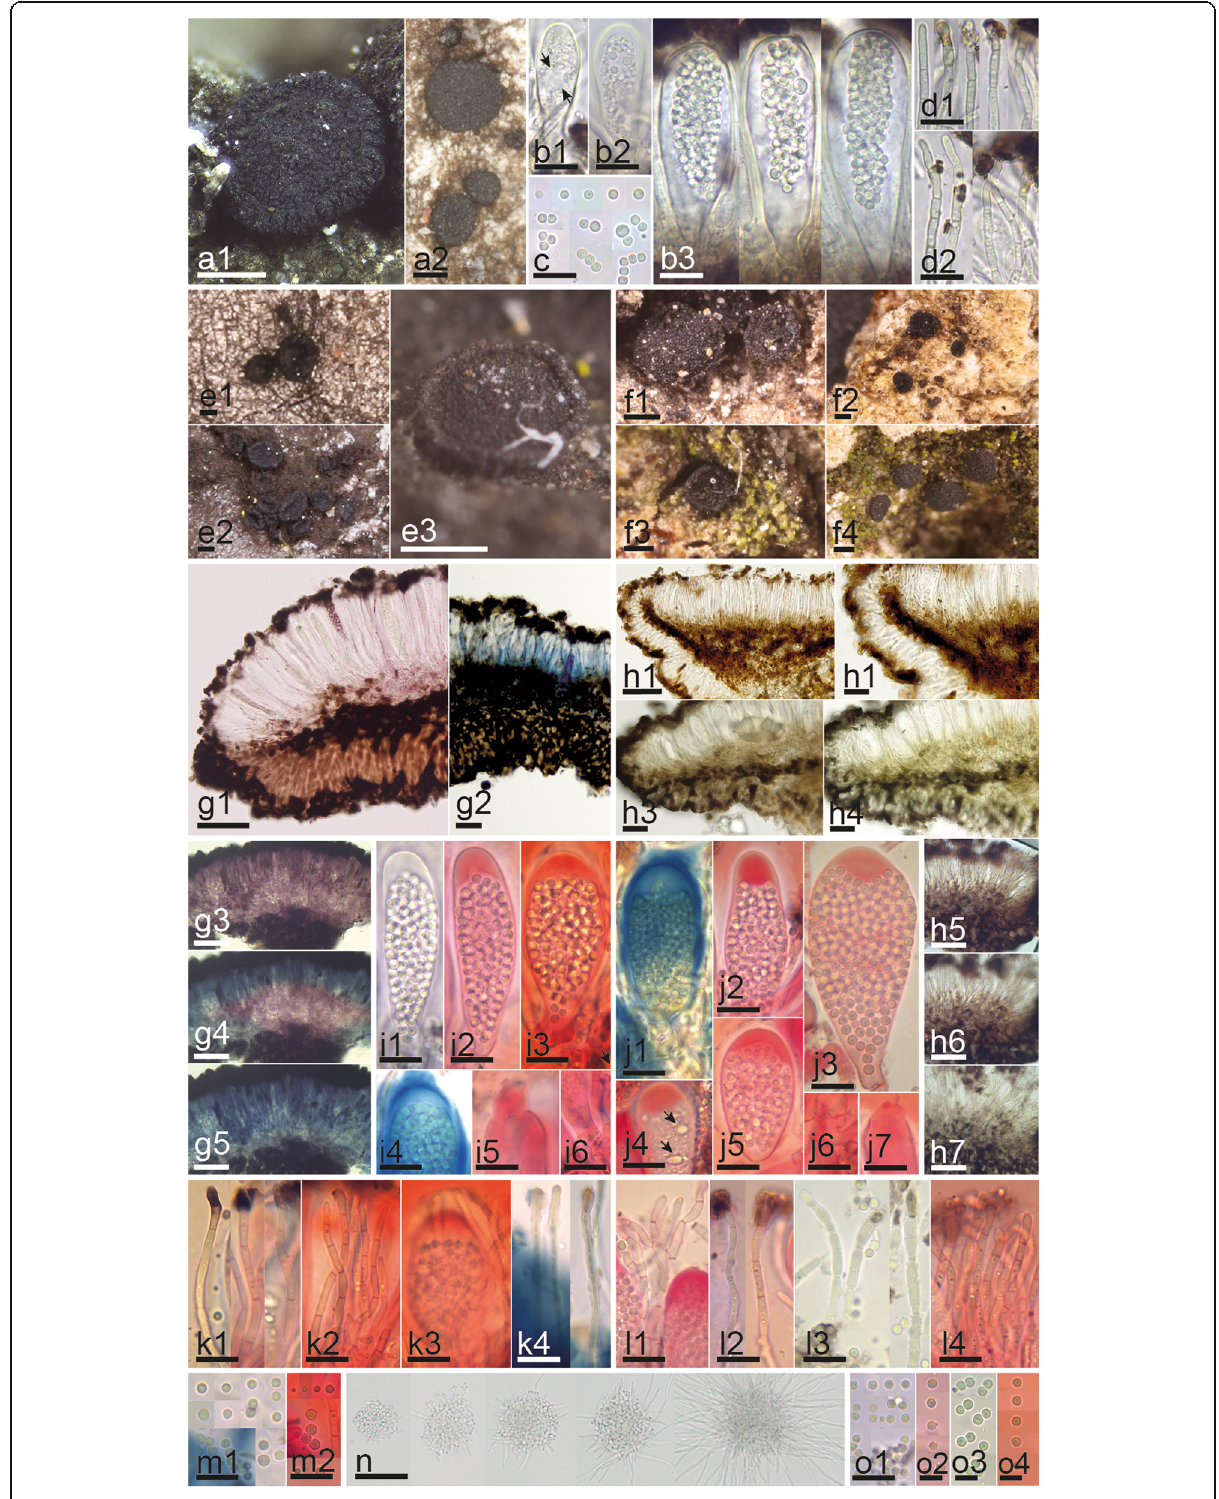
Fig. 1 (See legend on next